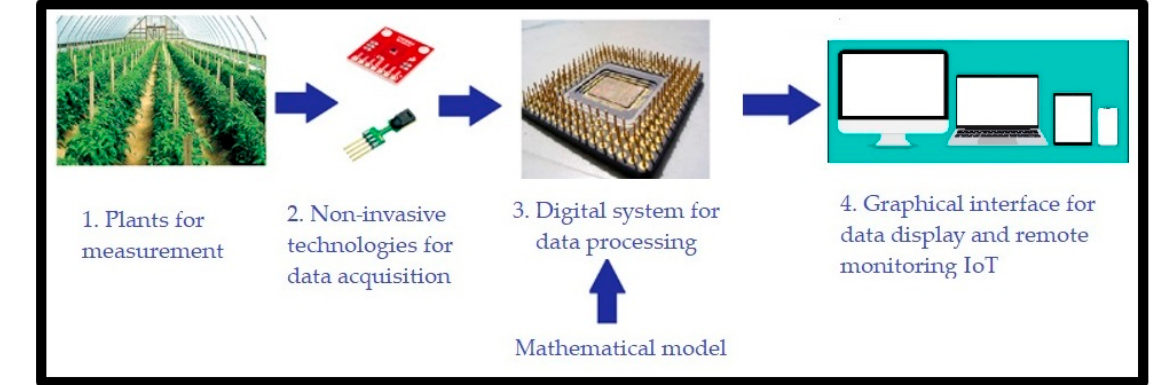
Figure 1. General scheme of the non-invasive IoT system to infer NP.